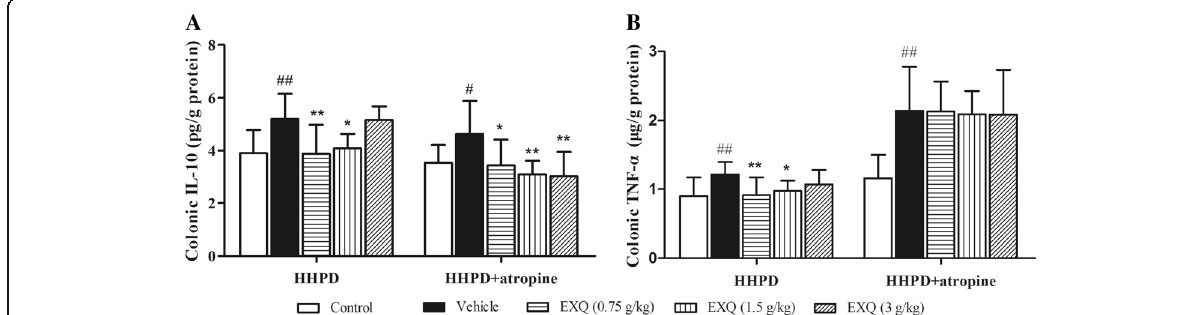
Fig. 4 Effects of EXQ on IL-10 and TNF- α levels in two models of experimental constipated mice. The levels of IL-10 ( a ) and TNF- α ( b ) were determined by ELISA. Data are presented as mean ± SD ( n = 8). # P < 0.05, ## P < 0.01 compared to the normal control group; * P < 0.05, ** P < 0.01 compared to the vehicle group